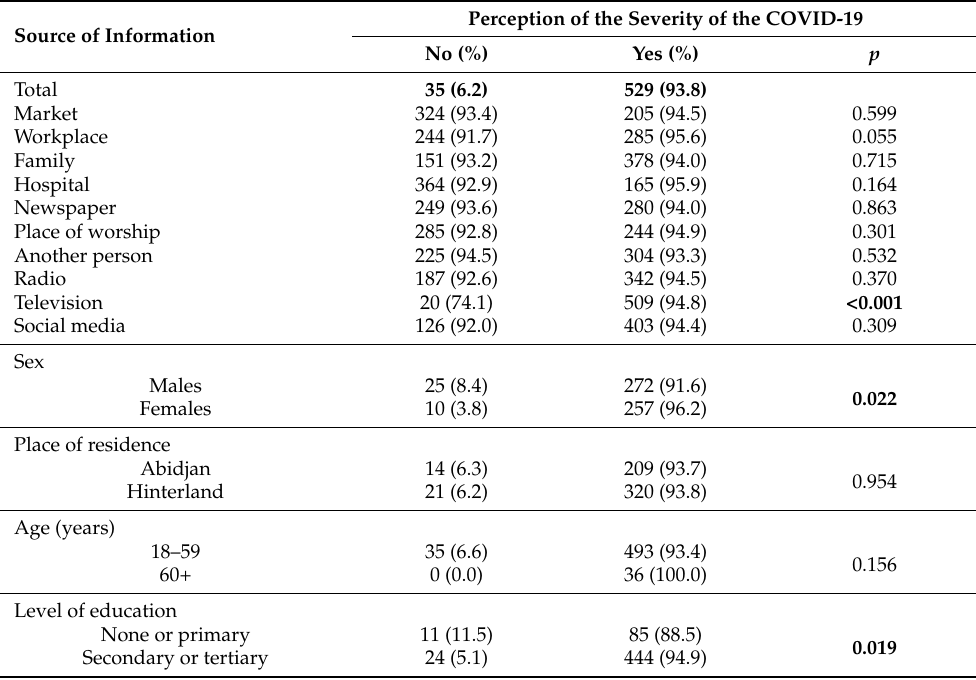
Table 2. Perception of the severity of the COVID-19 according to sources of information and socio- demographic characteristics of the